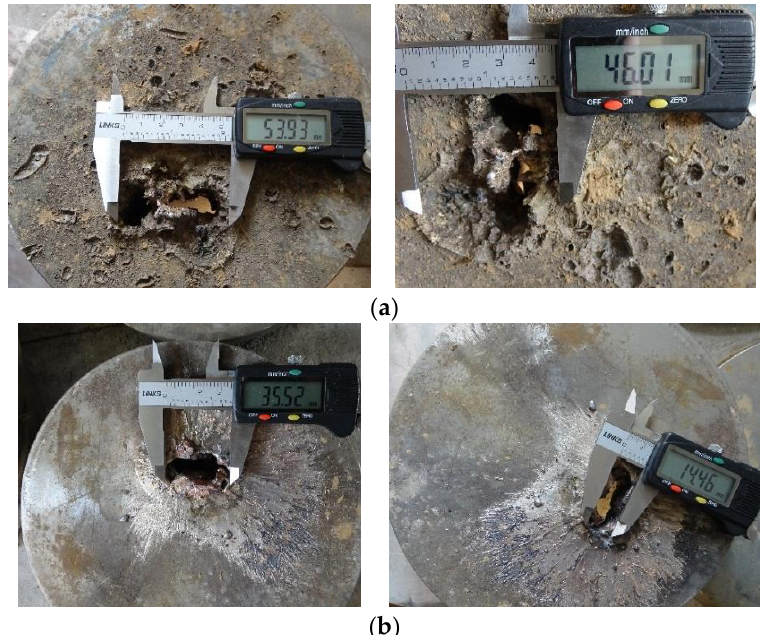
Figure 10. Penetration result of the Q235 steel target without the simulation cabin: ( a ) the size of the jet penetrating the Q235 steel target into the hole, ( b ) the size of the jet penetrating the Q235 steel target into the hole.